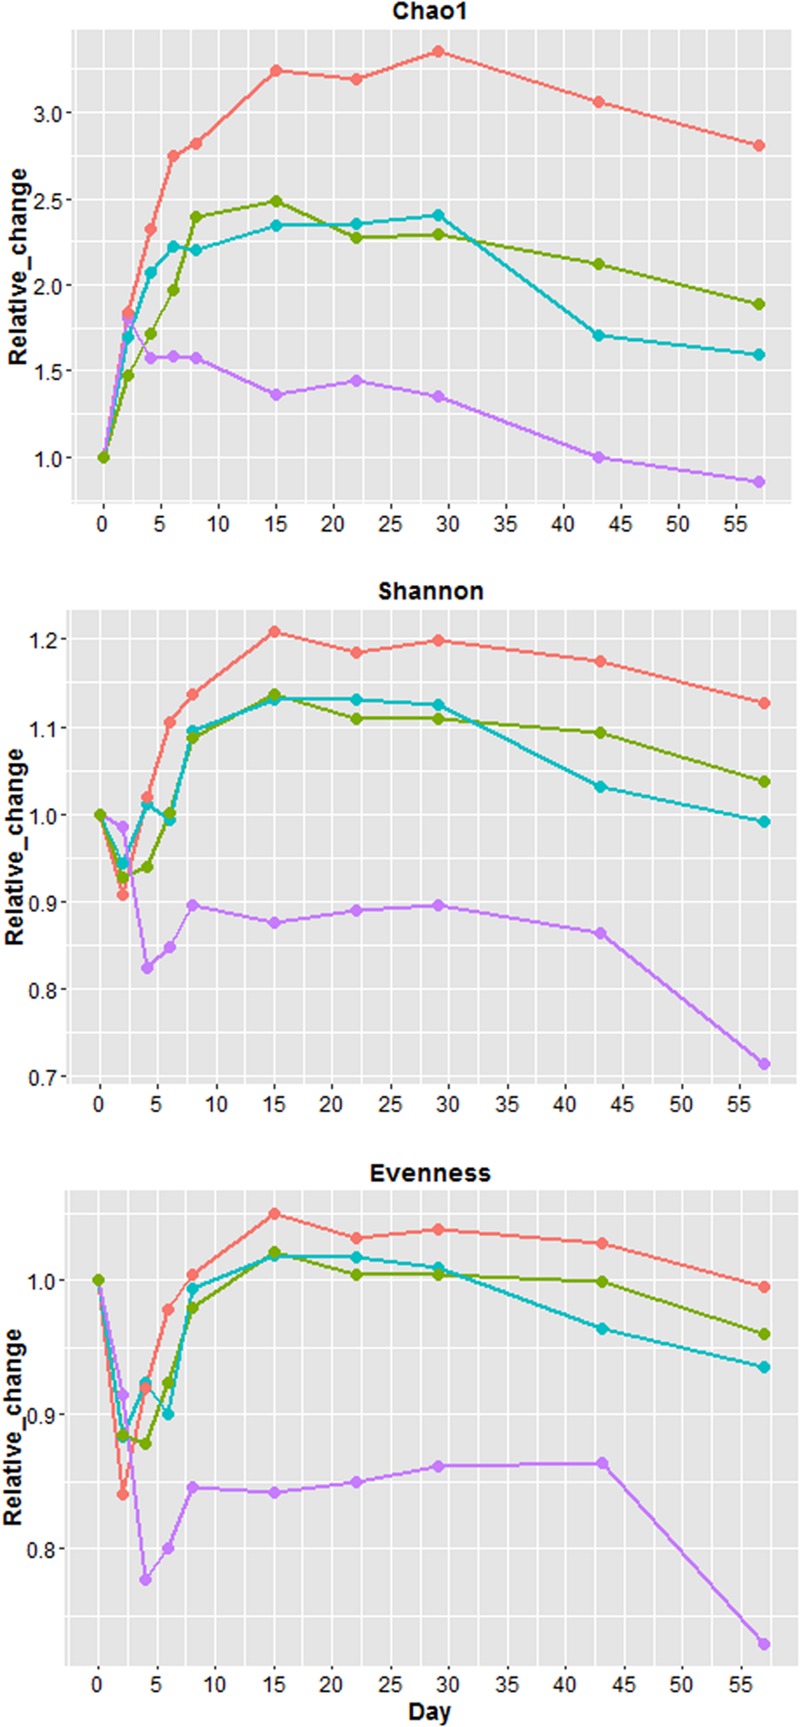
Relative changes in Chao1 (richness), Shannon index (diversity) and evenness. Relative change = (value of each sampling day)/(value of day 0). Blue = unshaded farm 1 (U1), Purple = unshaded farm 2 (U2), Green = shaded farm 1 (S1), Red = shaded farm 2 (S2).